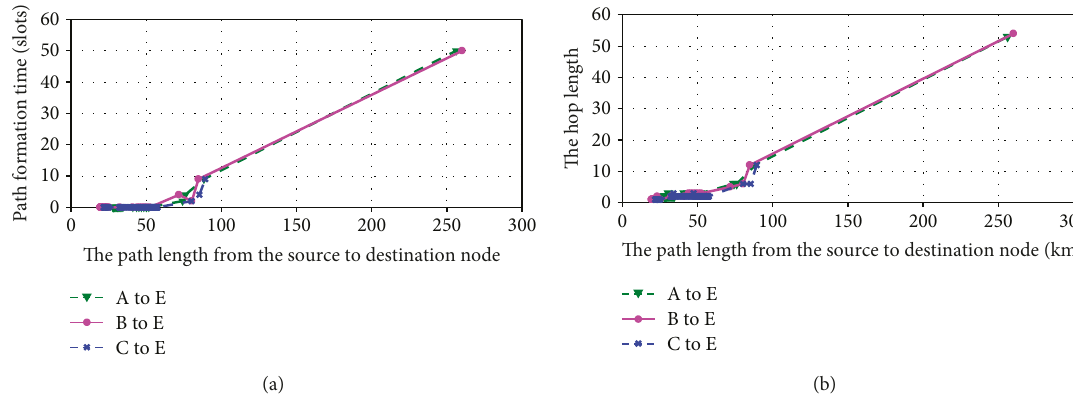
Figure 10: (a) The relationship between path formation time and path length. (b) The relationship between hop length and path length for di ff erent source-destination in the 5th orbit hyperperiod.